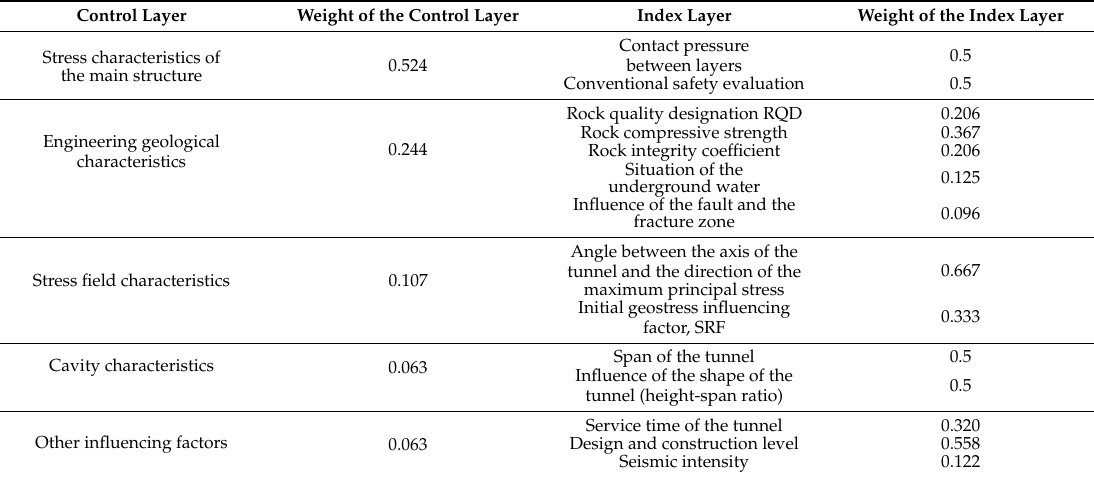
Table 5. Weight of each factor and its relevant indices in the evaluation